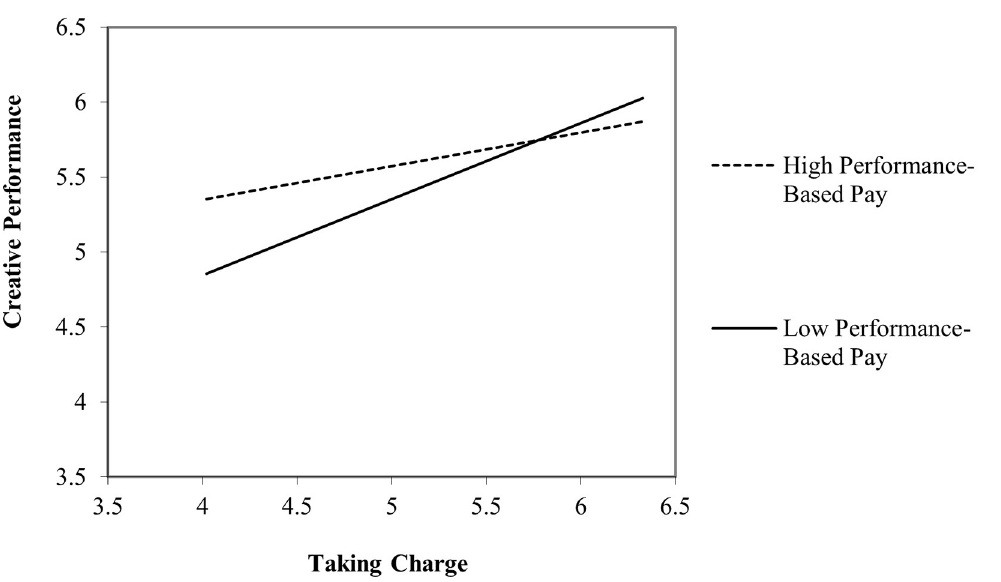
Fig 3. The moderating effect of performance-based pay on the relationship between taking charge and task